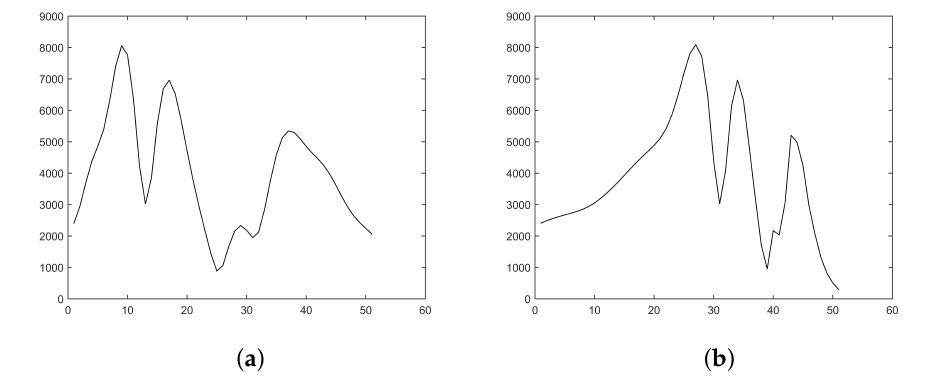
Figure 3. ( a ): y - z plane of the blur image with three points located at ( x , y ) = (0, 0.5 m), (0, 1 m), and (0, 2 m); ( b ): the result of log-polar transformation of the left one.The unit of x -axis is